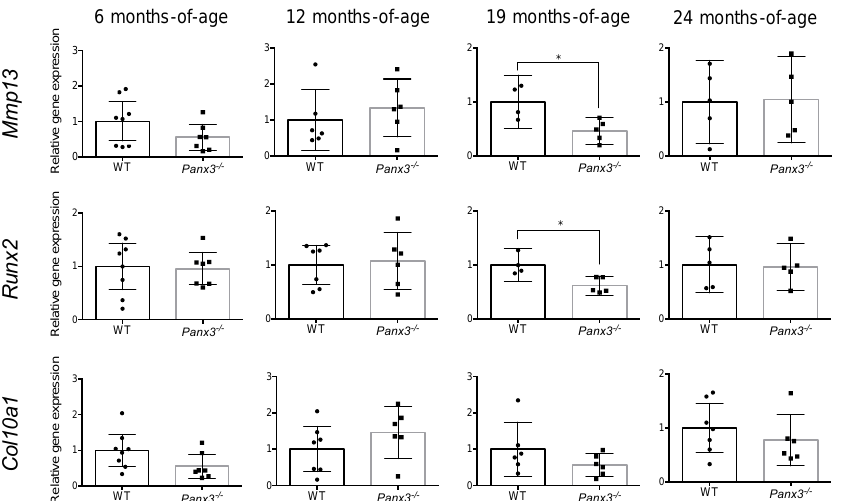
Figure 3. Effects of Panx3 deletion on expression of hypertrophic chondrocyte genes in the IVD. qPCR analysis of Mmp13 , Runx2 and Col10a1 gene expression in thoracic IVDs isolated from 6, 12, 19 or 24-month-old WT and Panx3 -/- mice. Gene expression was determined by relative quantification with values normalized to that of the Rps29 housekeeper and expressed relative to age-matched WT controls. Data are presented as mean ± 95% CI (* indicates p < 0.05, Welch’s t -test; n = 4–8 mice per group, 6–8 IVDs pooled per mouse). Values corresponding to each experimental animal are indicated by individual data points on bar graphs.